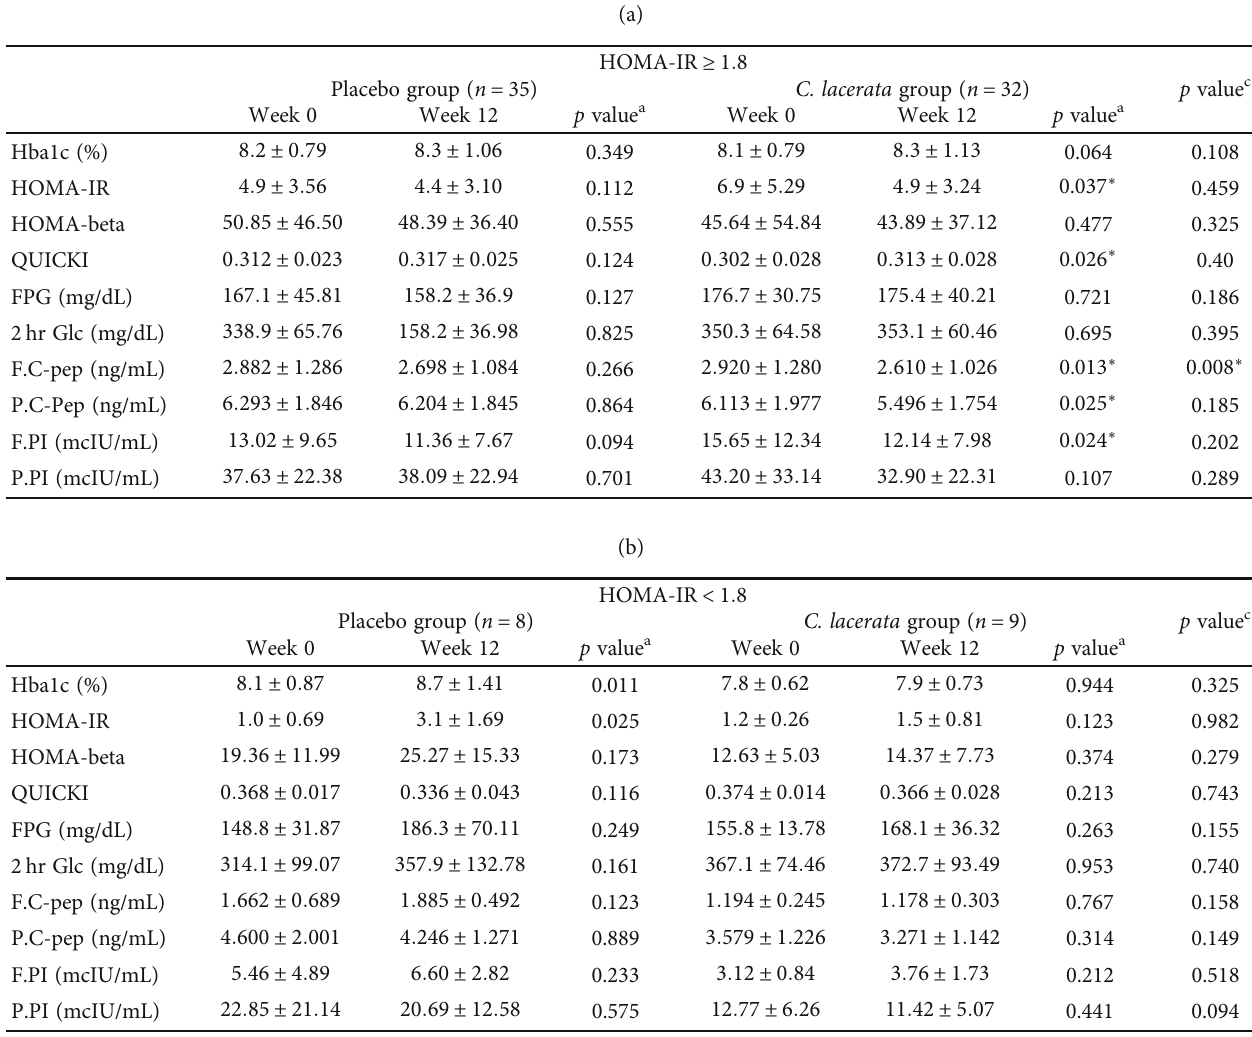
Table 4: Subgroup analysis of glycemic markers based on HOMA-IR.